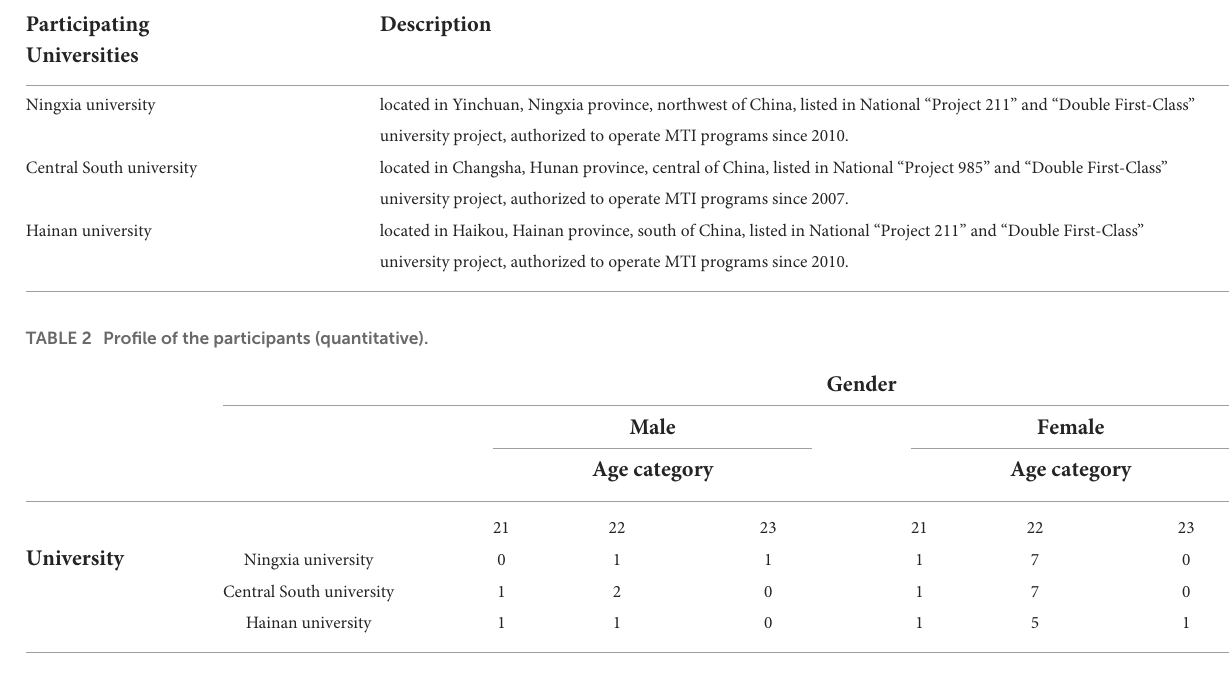
TABLE 1 Descriptive profiles of the three participating Chinese universities.